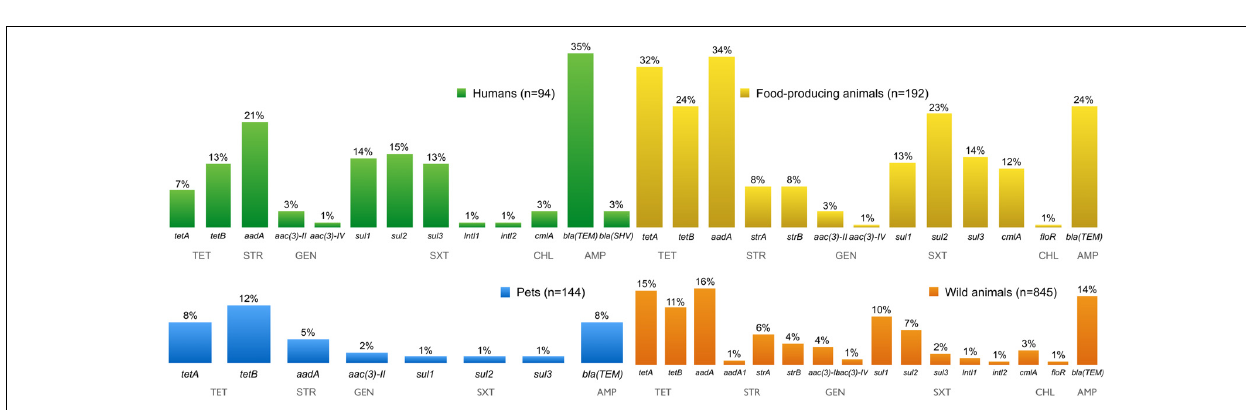
FIGURE 3 | Percentage of antimicrobial resistance (AMR) genes detected in E. coli resistant isolates from all sources over a